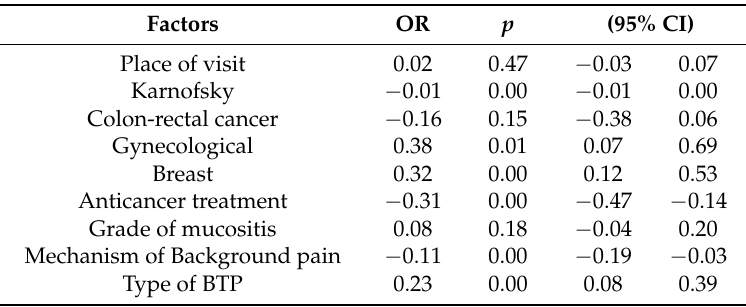
Table 5. Multivariate analysis for BTP slow onset.